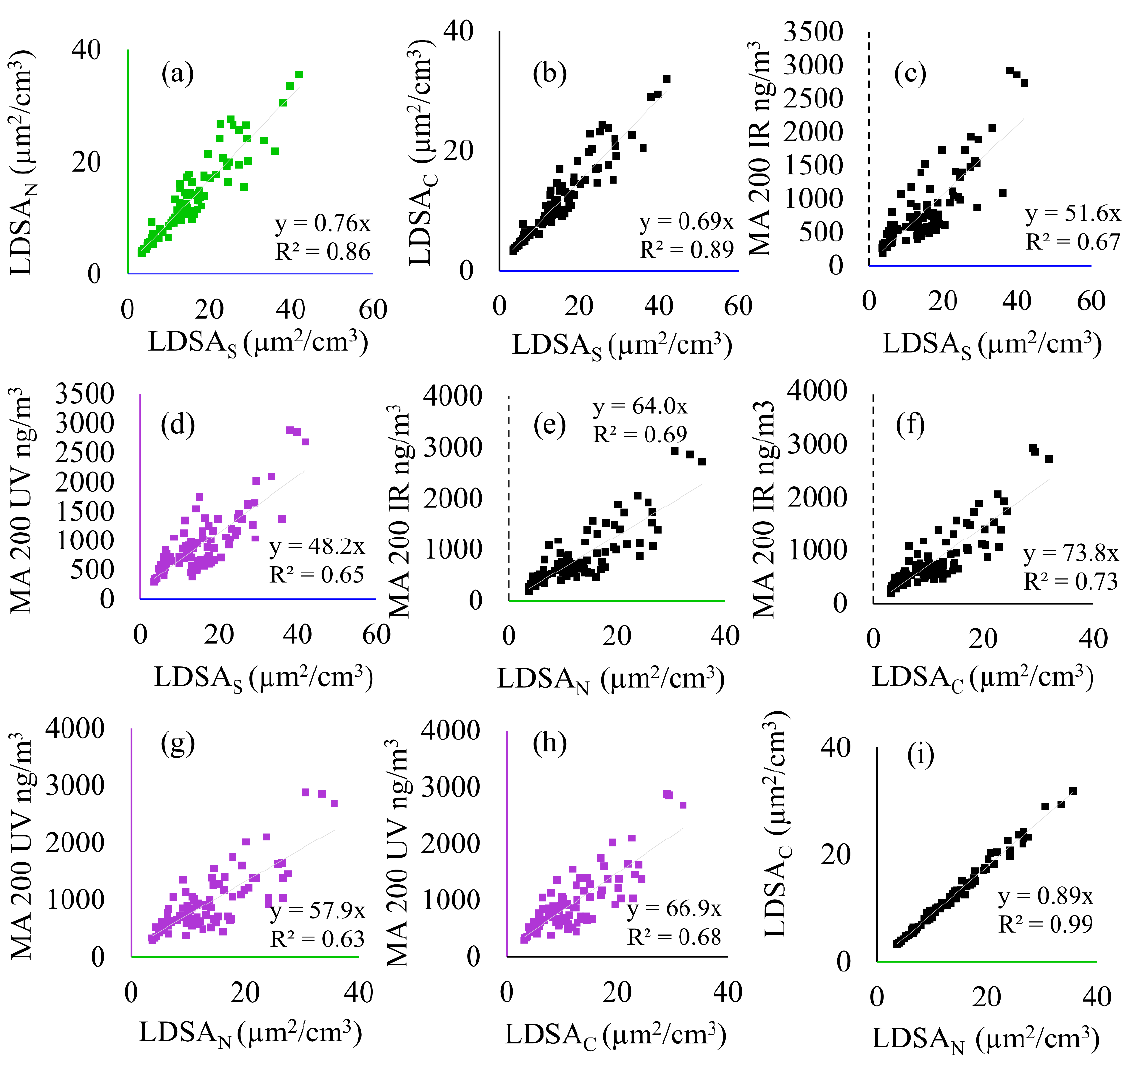
Figure 4. Correlation plots showing the linear regression and coefficient of determination (R 2 ) between all instruments including the SMPS (LDSA S ), MA200 (BC and BrC), and Naneos (LDSA N and LDSA C ) during Period 1. The following correlations are shown: ( a ) LDSA N to LDSA S , ( b ) LDSA C to LDSA S , ( c ) MA 200 IR to LDSA S , ( d ) MA 200 UV to LDSA S , ( e ) MA 200 IR to LDSA N , ( f ) MA 200 IR to LDSA C , ( g ) MA 200 UV to LDSA N , ( h ) MA 200 UV to LDSA C , and ( i ) LDSA C to LDSA N . Figure 4 details the correlation coefficients and coefficient of determination between all particle instruments during Period 1. The CO 2 correlations to the MA200 UV and IR wavelengths and the Naneos’ instruments are shown in Figure S2. Figure 4a,b,i show good inter-LDSA correlation (R 2 > 0.86), whereas correlation between LDSA and BC/BrC measures (Figure 4c–h) is lower (0.67 < R 2 < 0.73). In addition to the particulate data, wind speed, temperature and relative humid- ity data from the Meteorological Office were available for the entire period, shown in Figures S3 and